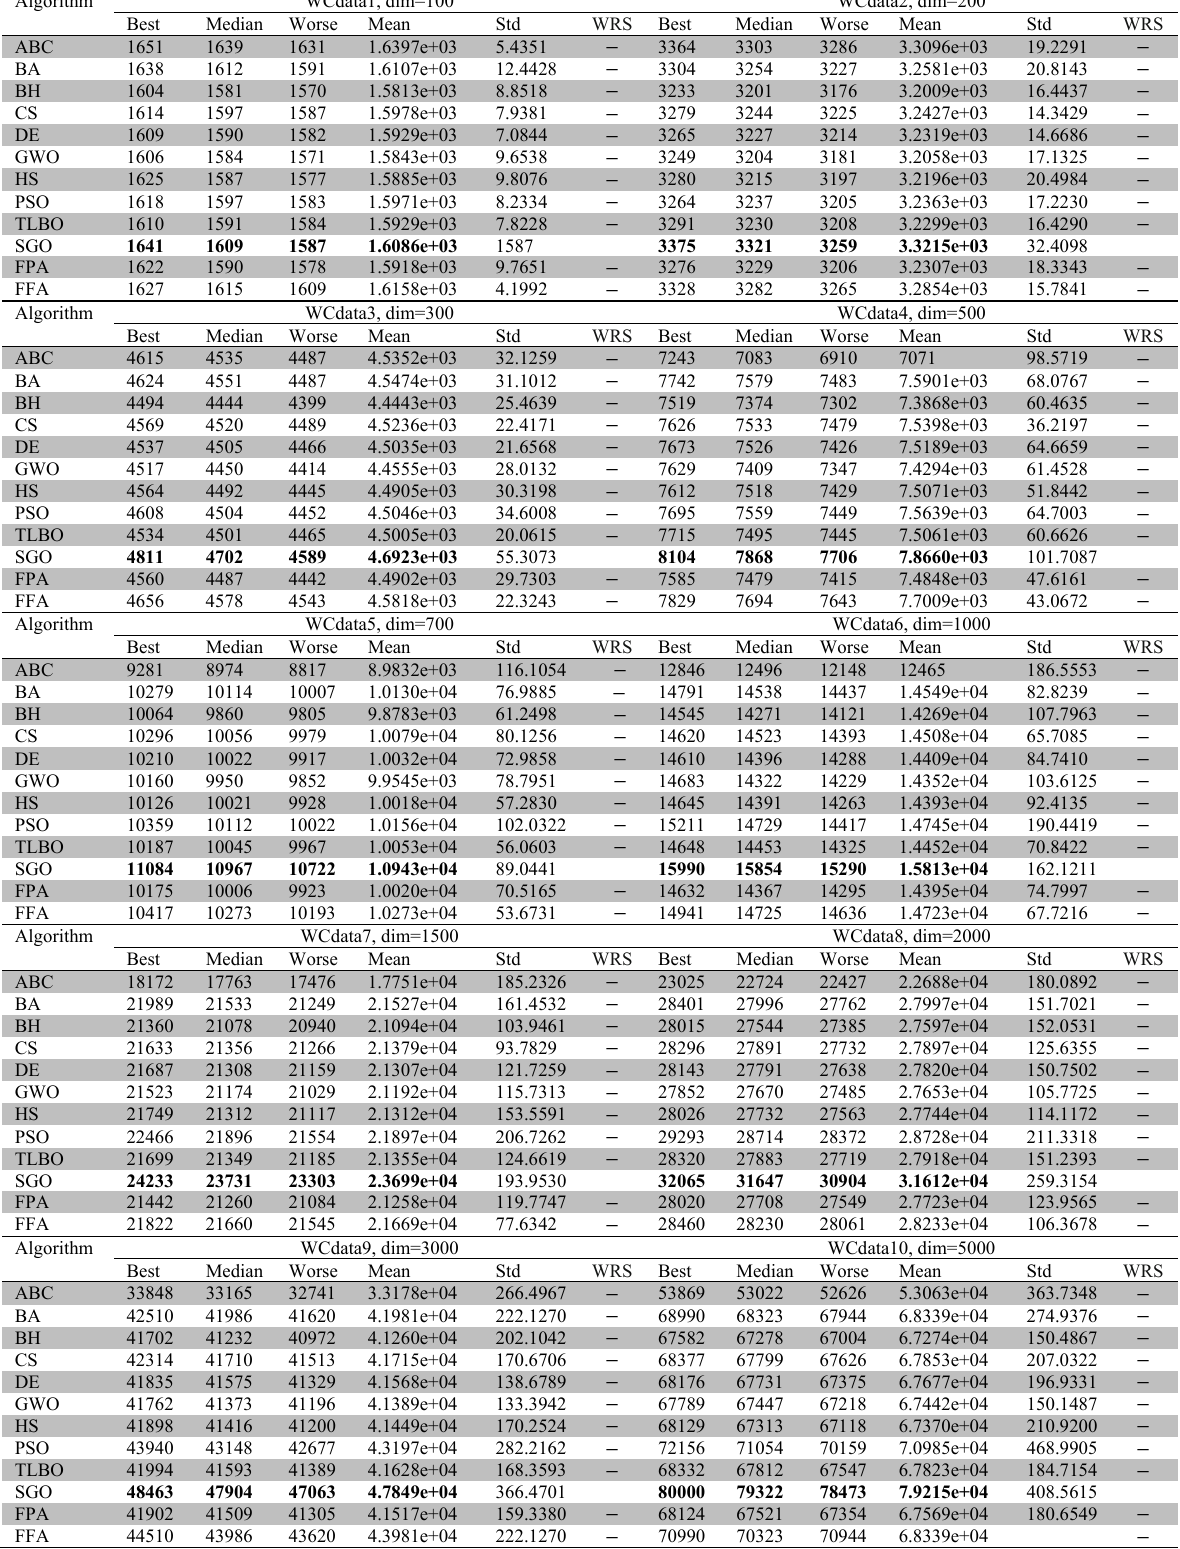
“ − ”, “ + ” and “ ≈ ” denote that performance of algorithms are worse, better and similar to BSGO respectively